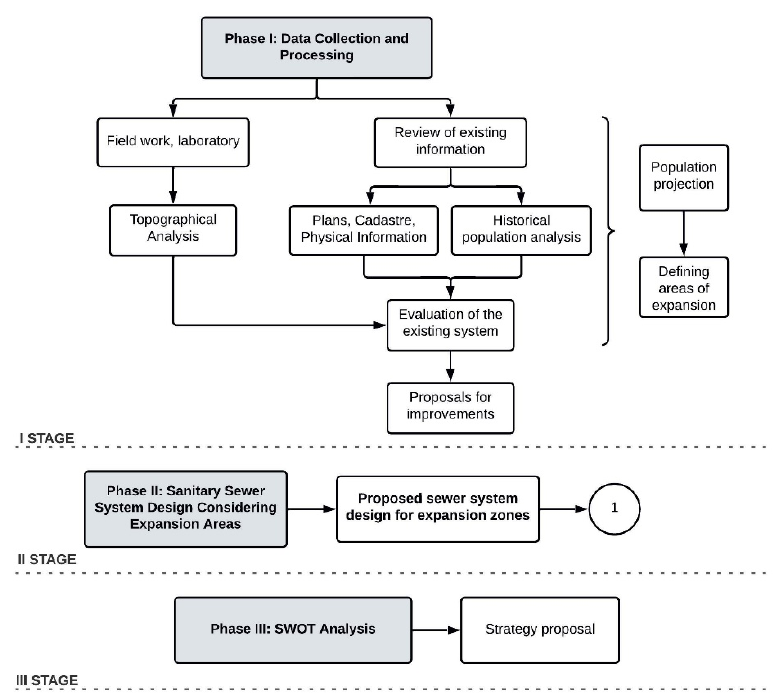
Figure 1. General scheme of the applied method.